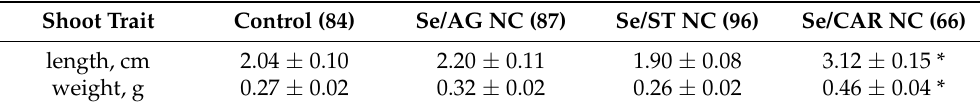
Table 2. Mean length and weight of potato shoots † ( ± SE) measured in the parental tubers after